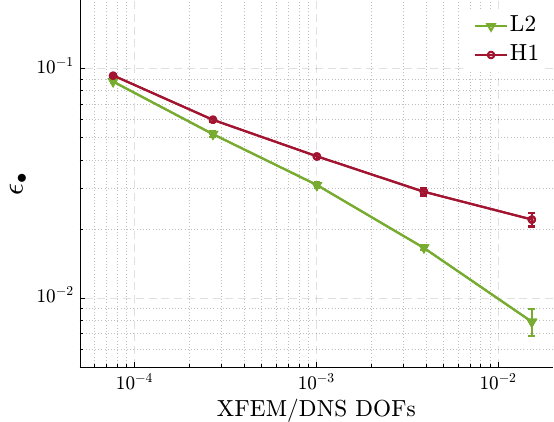
Figure 4. Convergence of L increasing number of DOFs in the coarse discretiza-